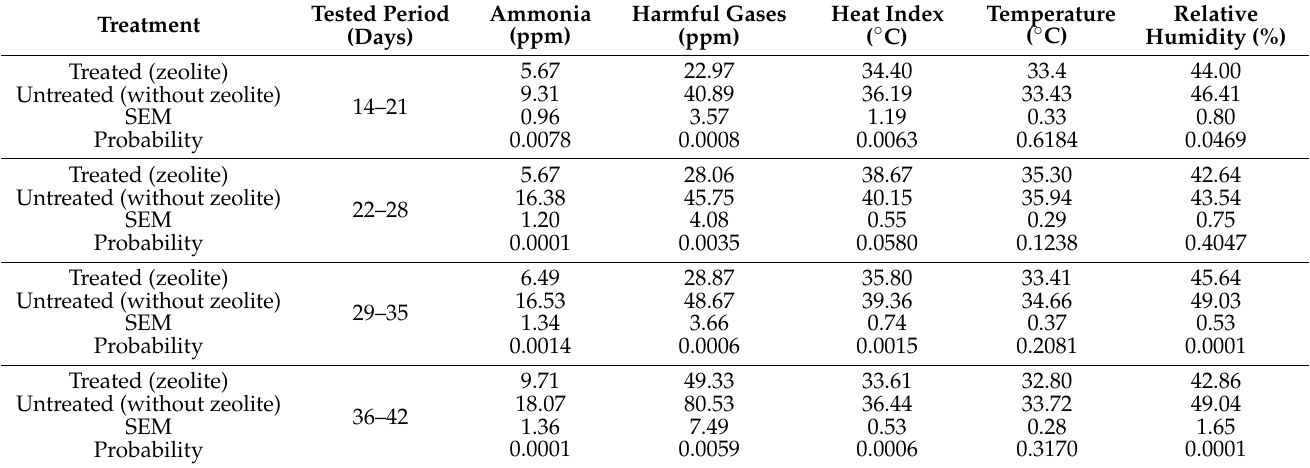
Table 1. Effect of treatment with zeolite on microclimate measurements during different tested periods.